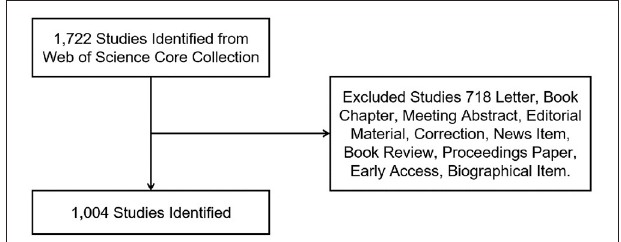
FIGURE 1 | Flow chart of music therapy articles and reviews